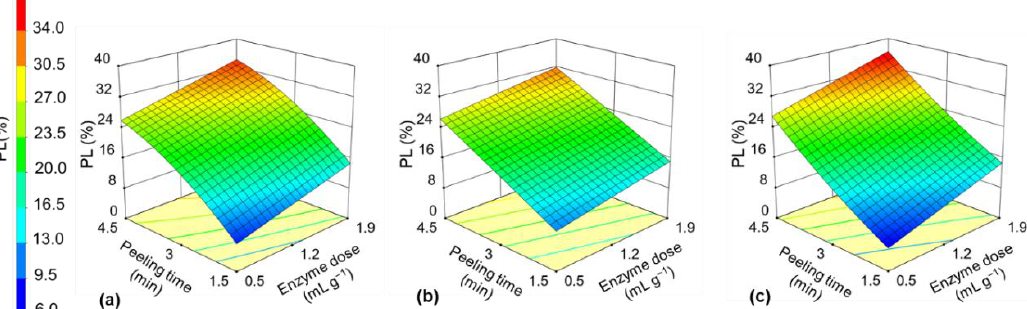
Figure 2. Peel loss (PL) of cassava tubers after enzyme treatment and mechanical peeling vs. peeling time and enzyme dose at incubation time of 4 h; ( a ) small, ( b ) medium and ( c ) large size of cassava tubers.